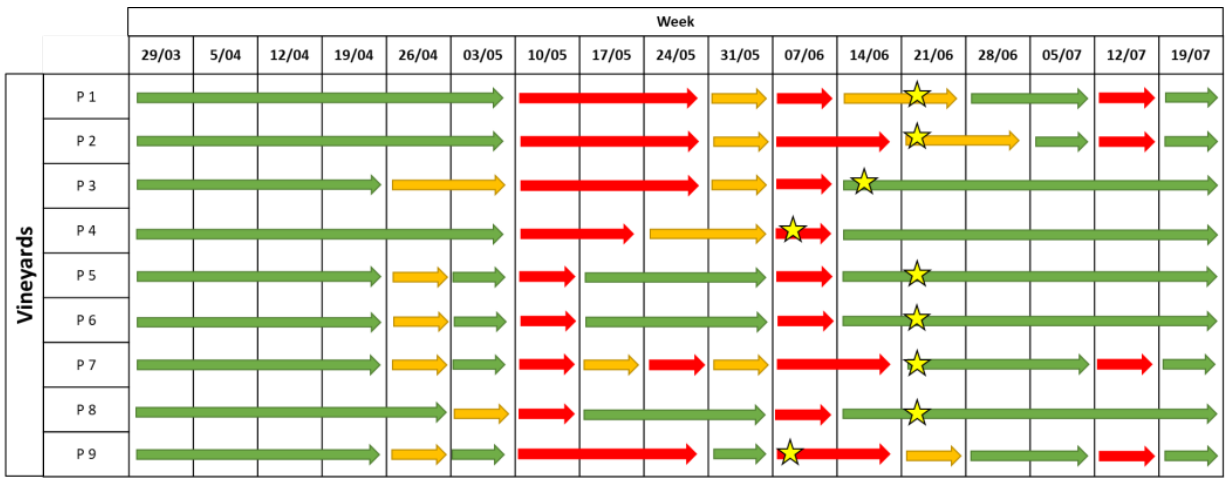
Figure 7. Levels of infection risk signalled by the EPI model. Coloured arrows indicate different levels of infection risk: red indicates a high infection risk, yellow indicates a medium infection risk, and green indicates a low infection risk. The stars indicate the moments when the first symptoms appeared in the field.